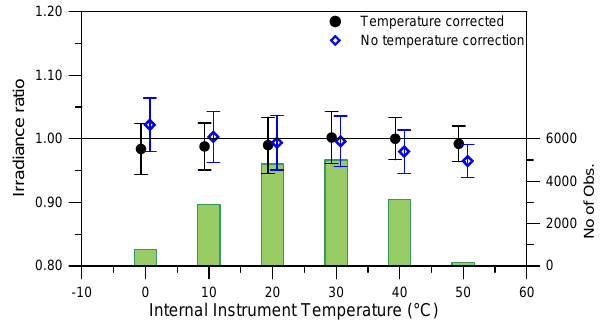
Fig. 9. Averages of the ratios (Brewer #086 over Brewer #005) of synchronous irradiance integrals (315–320nm) recorded by the two Brewer spectroradiometers as a function of the internal instrument temperature, in bins of 10 ◦ C. Filled circles correspond to tempera- ture corrected data and rhombuses to data uncorrected for tempera- ture effects. The error bars correspond to one standard deviation.